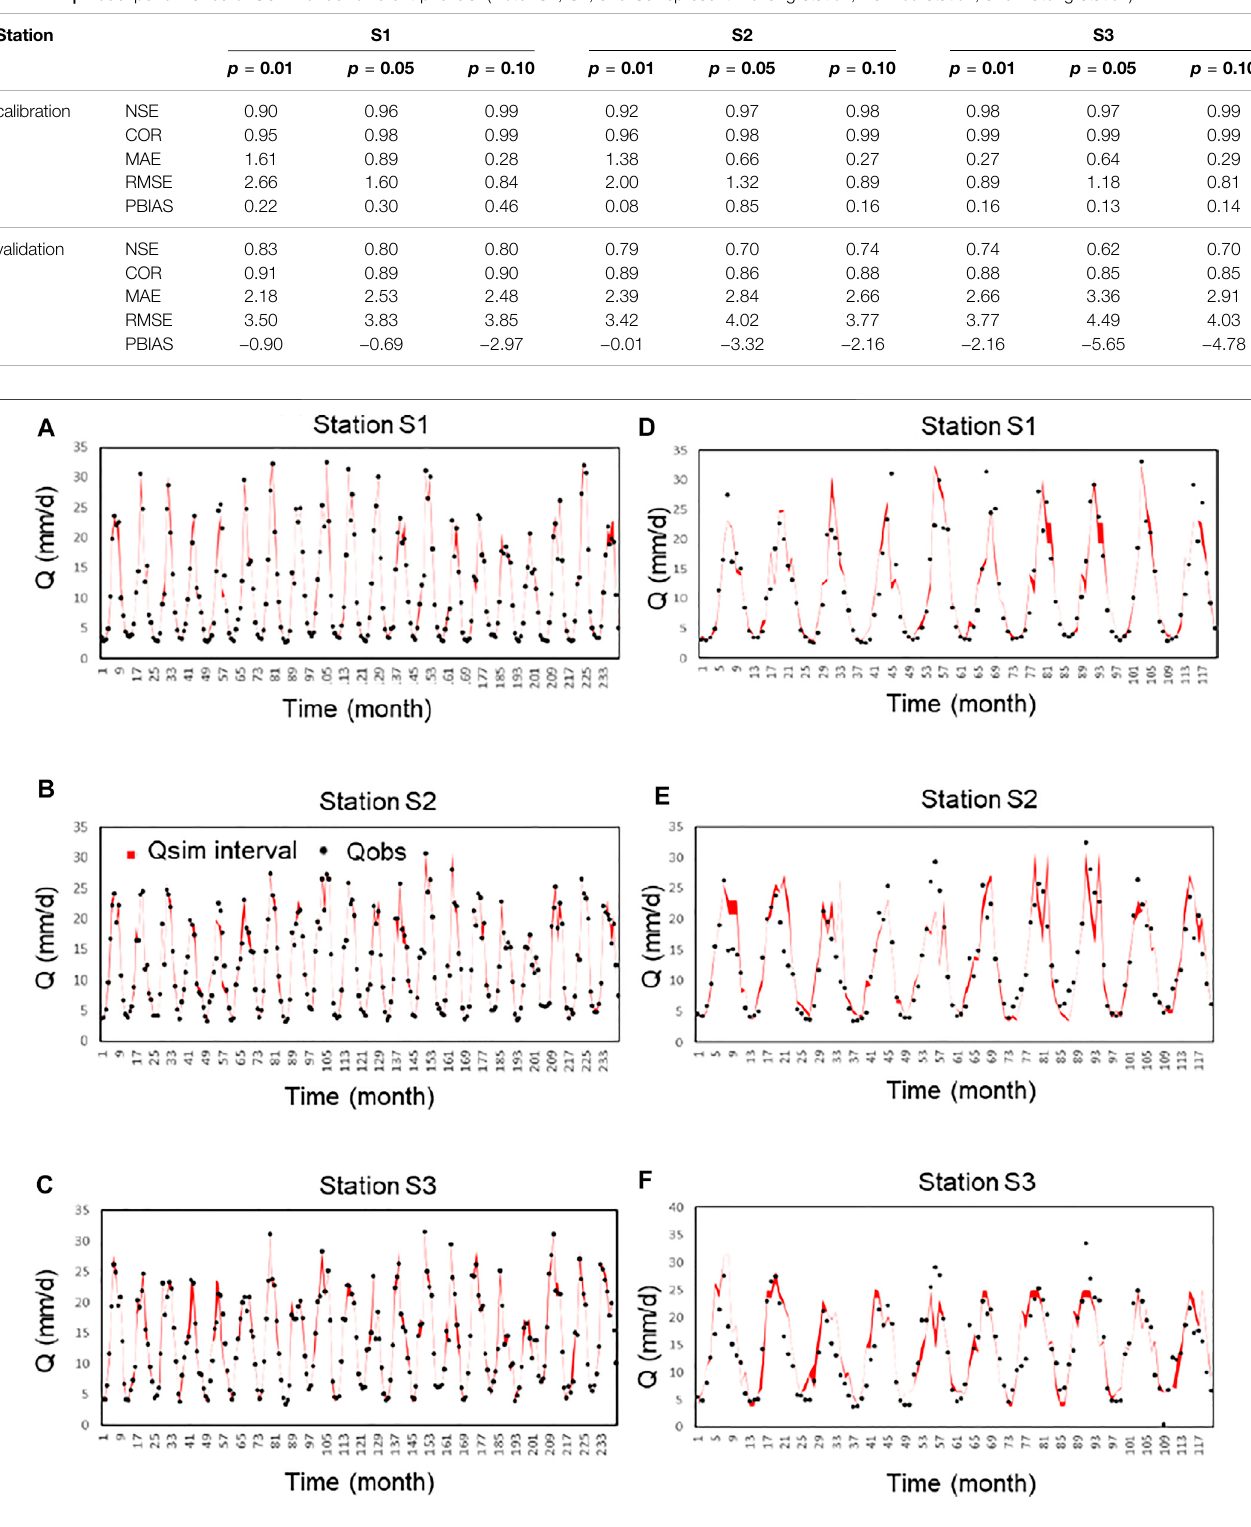
TABLE 4 | Model performance of SCAH under different p levels. (Note: S1, S2, and S3 represent Yichang station, Hankou station, and Datong station). Station